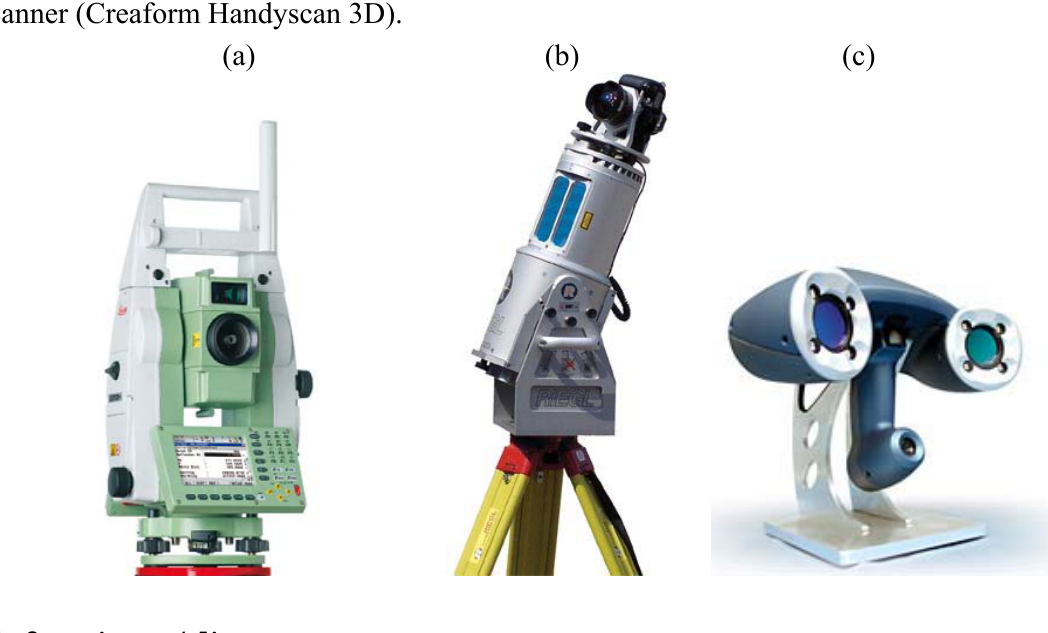
Figure 2. (a) Example of a total station (Leica TPS1200+ Total Station); (b ) example of a 3D time of flight laser scanner (Riegl LMS-Z420i); (c) example of a 3D triangulation laser scanner (Creaform Handyscan